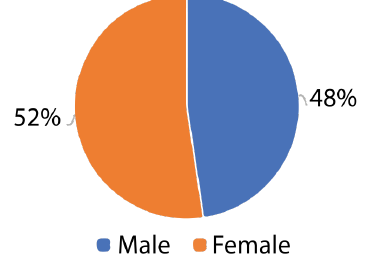
Figure 16. Classification of users by sex.